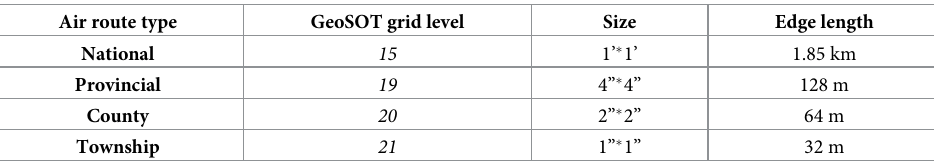
Table 1. Air route type